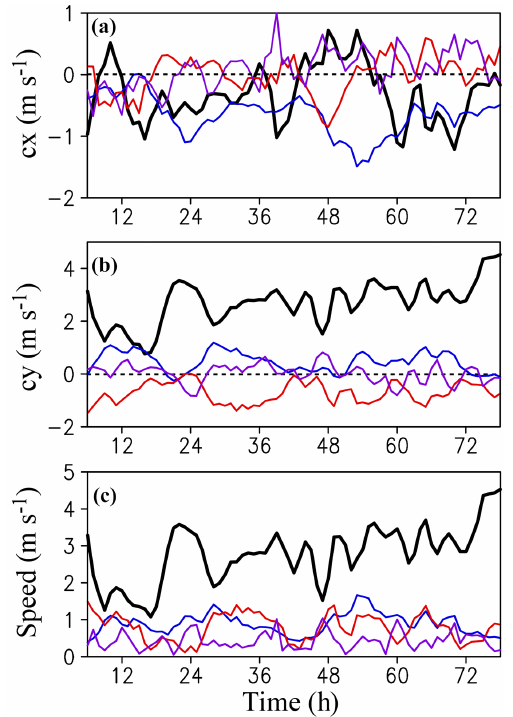
Figure 7. Contributions of the horizontal advection (HA, black), vertical advection (VA, blue), diabatic heating (DH, red) and fric- tion (FR, purple) terms in the PVT equation to tropical cyclone mo- tion: (a) zonal component, (b) meridional component and (c) mag- nitude.